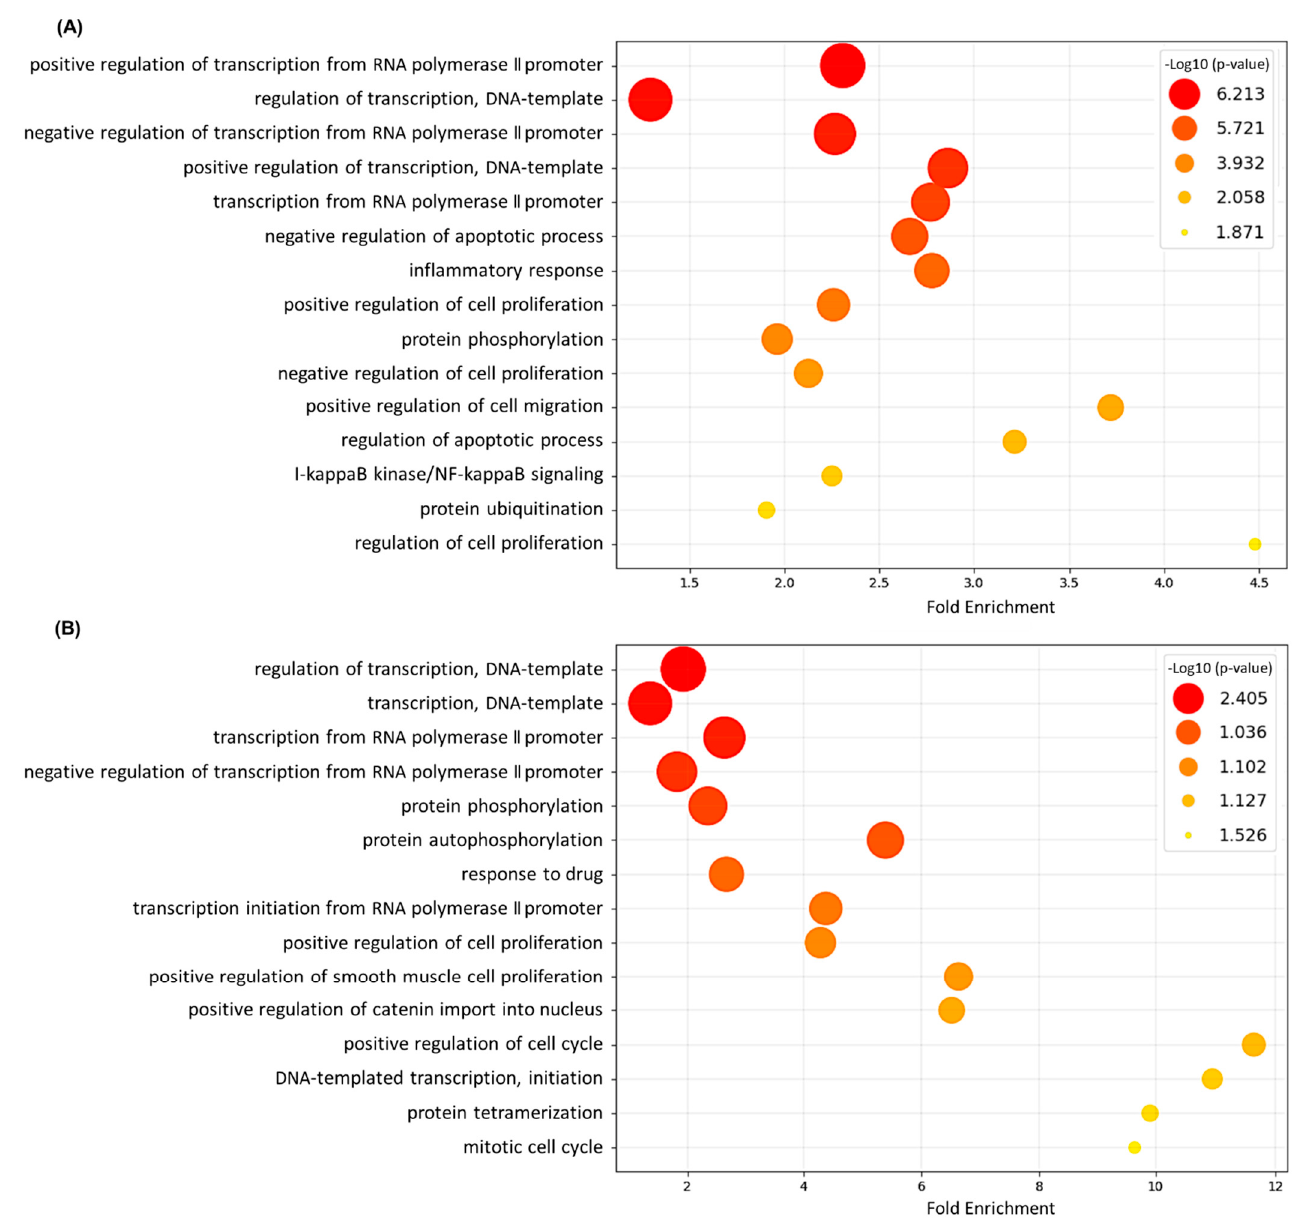
Figure 2. Biological processes in GO enrichment analysis of DEGs. GO enrichment analysis was performed on None vs. HP pair ( A ) and HP vs. ASTX + HP pair ( B ). The color and size of each bubble represents the –Log10 values, and fold enrichment scores are represented on the horizontal axis.